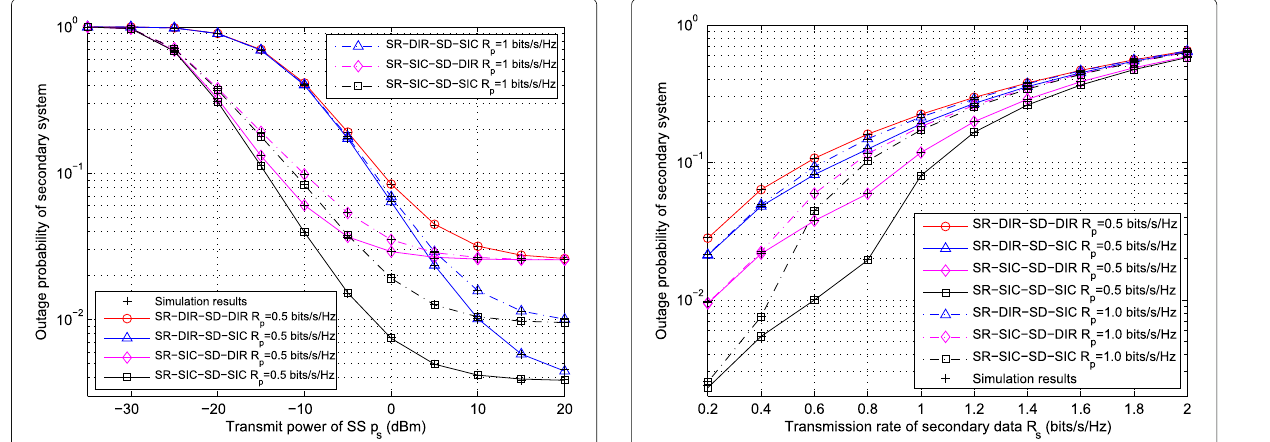
method of Section 6. The minimum outage probability of secondary system is obtained while guaranteeing the per- formance constraint of primary system. In obtaining the following numerical results, we set ρ = 3 and R s = 0.3